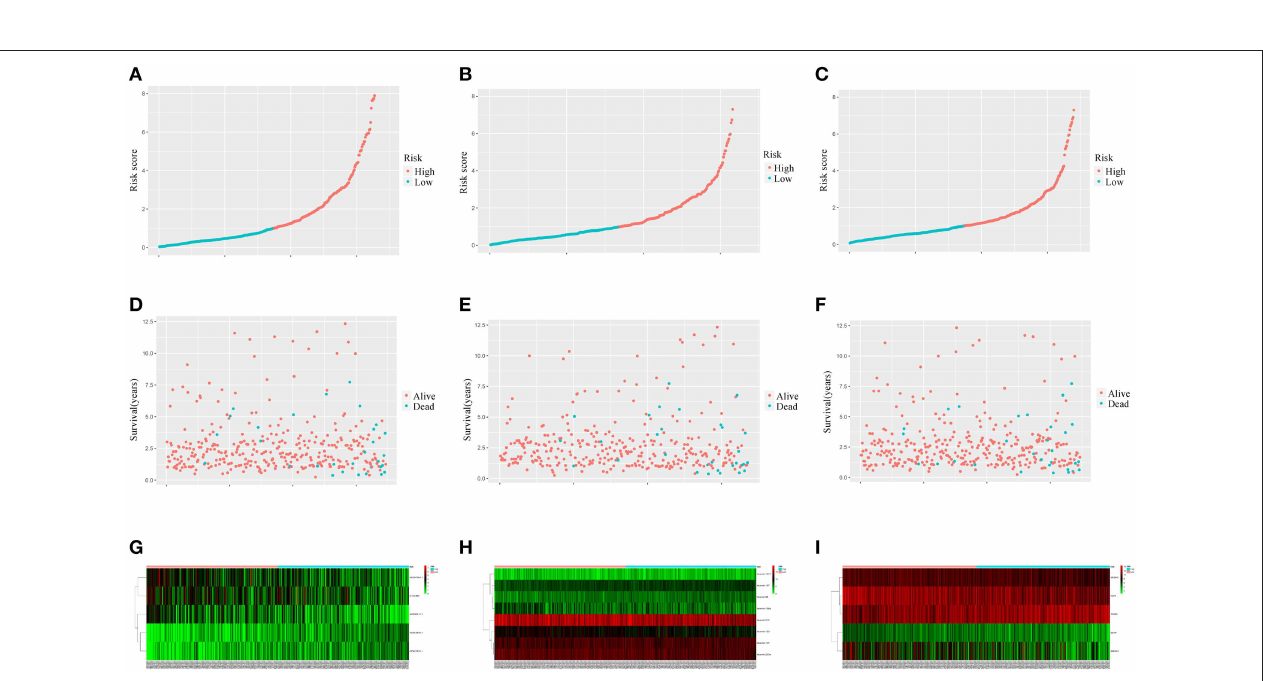
FIGURE 7 | Performance of the prognostic models in distinguishing patients into low-risk and high-risk groups. The risk score distribution in the lncRNA-based model (A) , the miRNA-based model (B) , and the mRNA-based model (C) . The risk score distribution of survival status in the lncRNA-based model (D) , the miRNA-based model (E) , and the mRNA-based model (F) . Heatmap of the lncRNA (G) , miRNA (H) , and mRNA (I) expression profiles between the low risk score and high risk score groups.